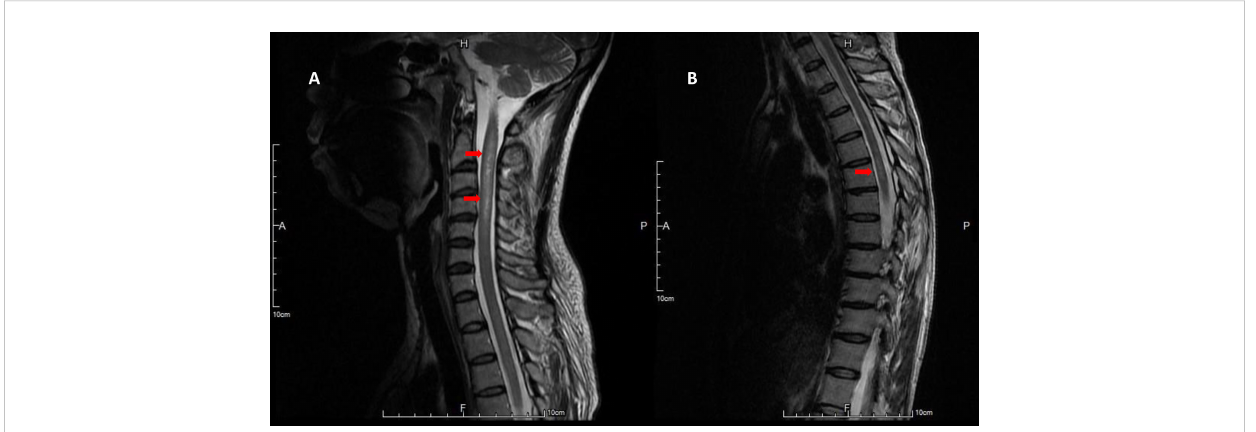
FIGURE 1 Hyperintense lesions at C2-4 level on T2-weighted image of spine MRI (A) . Faint high signal intensities at T5-6 level on T2-weighted image of spine MRI (B)